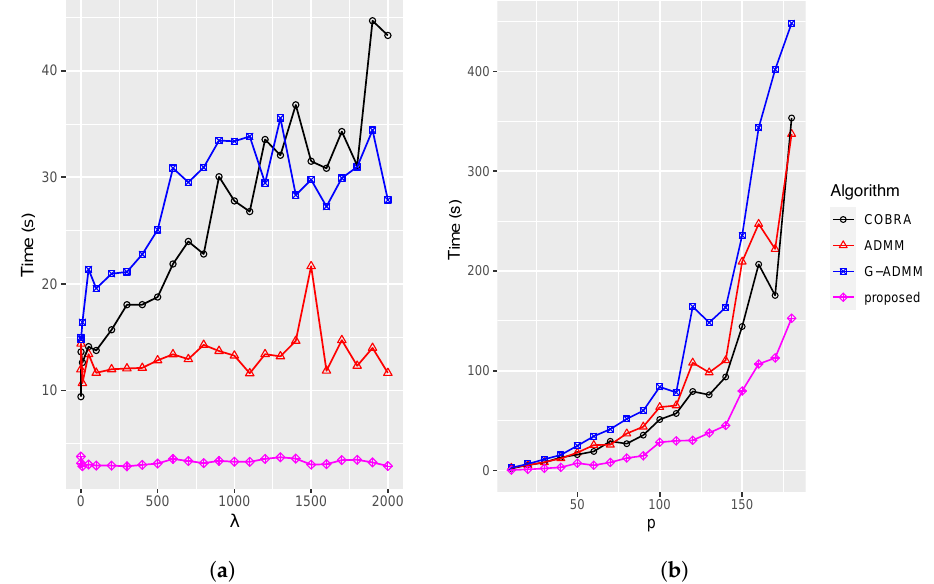
Figure 2. Execution time for various λ and p with N = 100 and (cid:101) = 1 × 10 − 6 . ( a ) Different λ , with p = 40; ( b ) different p , with λ =